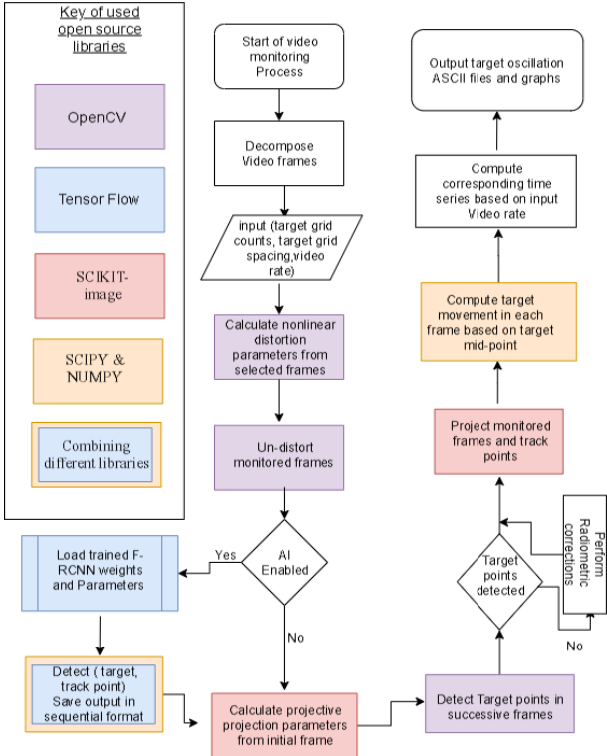
Figure 7. Flowchart presenting proposed monitoring workflow.